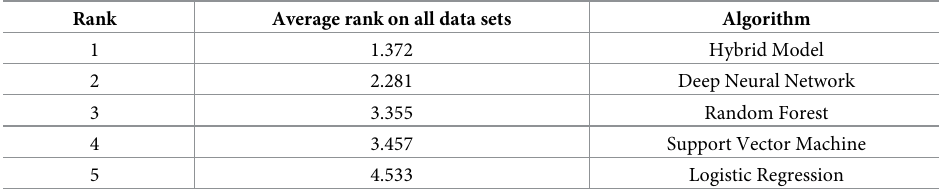
Table 6. The algorithms ranking.